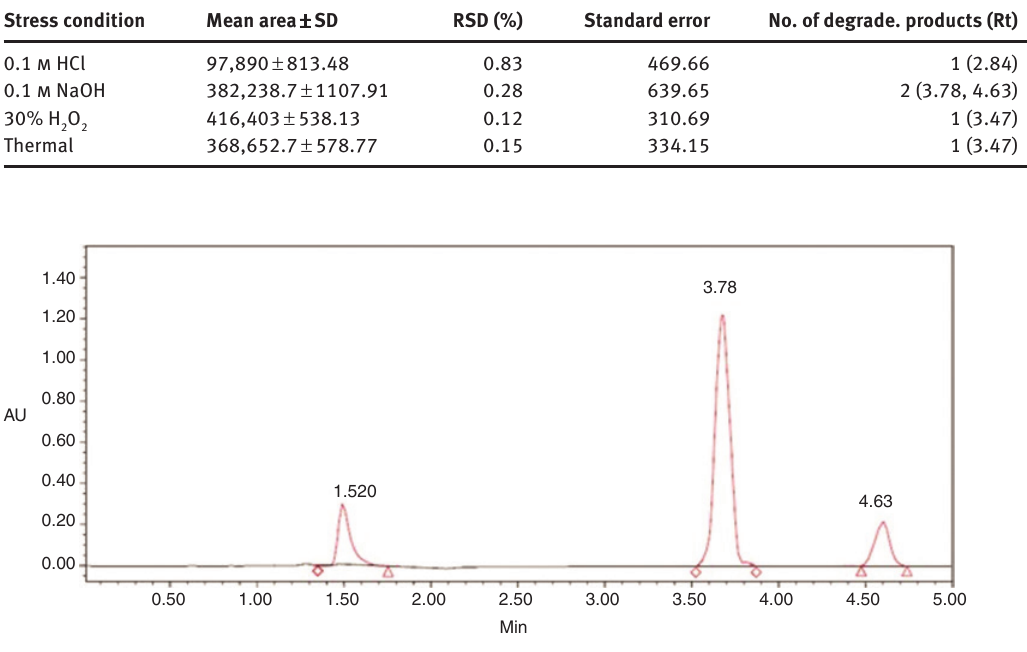
Figure 4: HPLC chromatogram of rosuvastatin in the presence of 0.1 m NaOH.